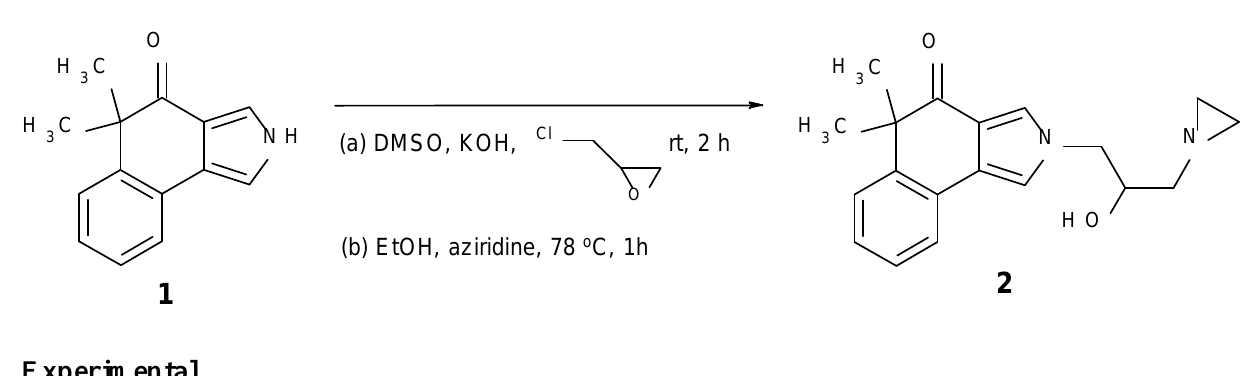
Experimental 2-[3-(Aziridin-1-yl)-2-hydroxypropyl]-5,5-dimethyl-2,5-dihydro-4H-benzo[e]isoindol-4-one ( 2